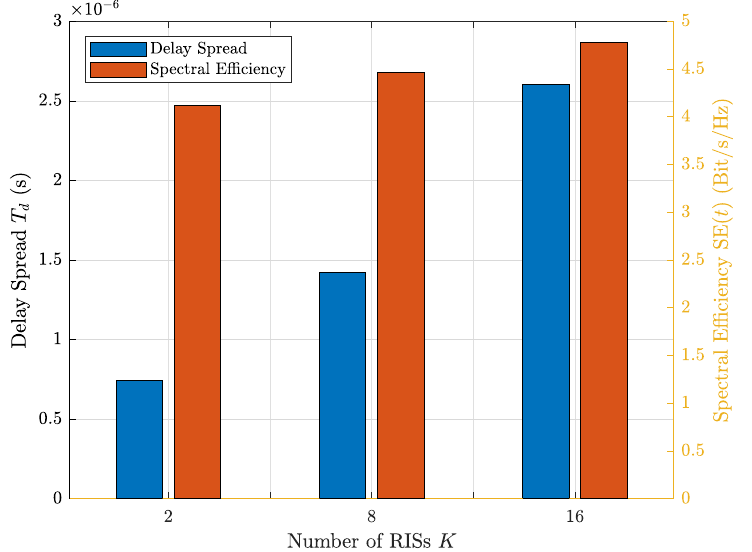
Figure 12. Average delay spread and spectral efficiency for different K . a HWI = π /2, and κ t = κ r = 0.05 2